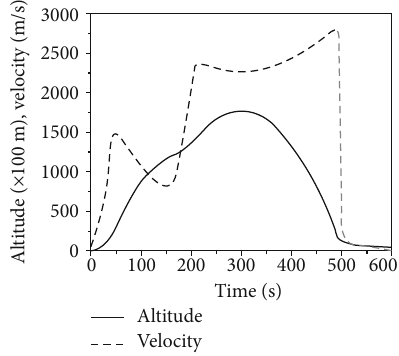
Figure 2: DMARS data of the SHEFEX II trajectory [14]. Black lines give in- fl ight measurement, and gray lines give the assumed subsequent fl ight